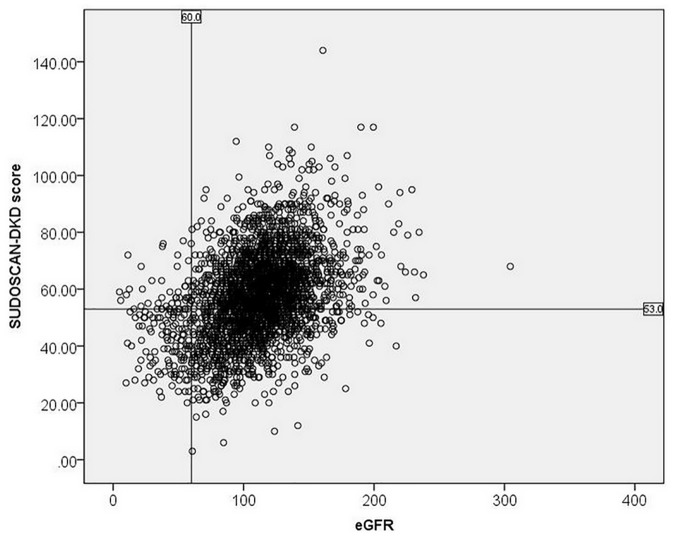
Scatterplot showing the relationship between SUDOSCAN-DKD score on y-axis and estimated glomerular filtration rate on x-axis.